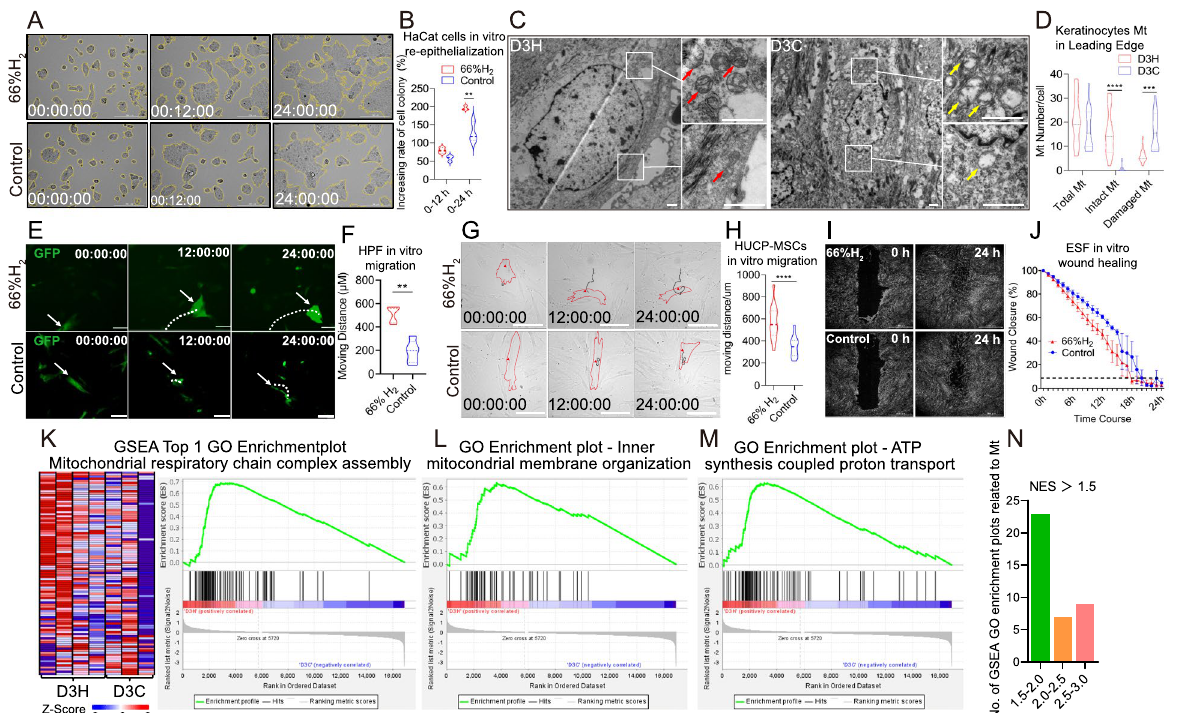
Fig. 5 H 2 promoted in vivo and in vitro keratinocytes and fibroblasts cells viability by accelerating the re-epithelialization, migration and mitochondrial functions. A . Representative images of HaCat cell epithelization. Images were captured every two hours using a live cell imaging system, and the 0, 12 and 24 hour images were presented. B . The increased rate of the total colony area in 12 and 24 hours. C . Comparison of mitochondrial morphology 3 days post-wound for the D3H and D3C groups observed by electron microscope. The right two images in each panel are enlargements of the white frames in the left images. Red arrows indicate intact mitochondria, while yellow arrows indicate damaged mitochondria. D . Comparison of total mitochondria, intact mitochondria and damaged mitochondria numbers between D3H and D3C groups. E and G . Representative images of HUCP-MSCs and HPF fibroblasts migration at 0-h, 12-h, and 24-h time points in H 2 medium and control groups. F , H Graphic analysis of HUCP-MSCs and HPF fibroblasts total moving distance in 24 h. I . Cell migration ability examined by wound-healing assay in H 2 medium and control groups. J Wound-healing curve analysis under different conditions. K Heatmap and enrichment plot showing genes related to mitochondrial respiratory chain complex assembly, which is the top 1 GO enrichment function in D3H. L , M Top GO enrichment plots in D3H related to inner mitochondrial membrane organization and ATP synthesis-coupled proton transport, which indicates more intact and functional mitochondria in D3H. N GSEA GO enrichment plots enriched in Mt related functions for D3H (NES > 1.5). White and black dotted lines in E and G indicate the migration route of fibroblasts. Red dotted line in G . outlines the representative HUCP-MSCs. Data in B and D processed two-way ANOVA test, and data in F , H , and J processed unpaired t test. Data were plotted as mean SEM. * P value < 0.05; ** P value <0.01; *** P value < 0.001; ± no stars for P value > 0.05; Scale bar in A and